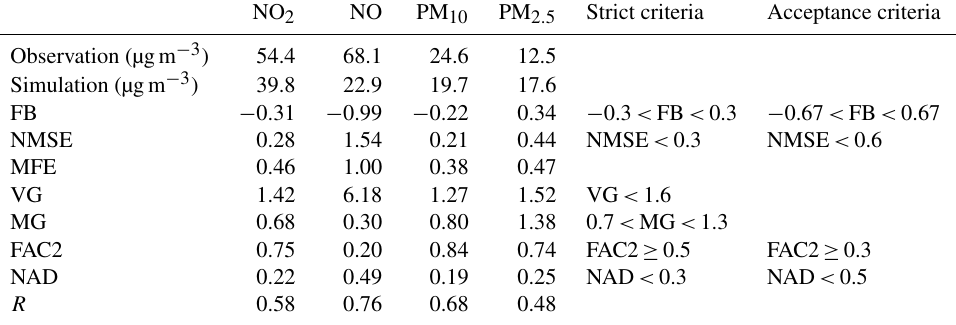
Table 3. Statistical indicators of the comparison of simulated hourly concentrations to the measurements at the air monitoring